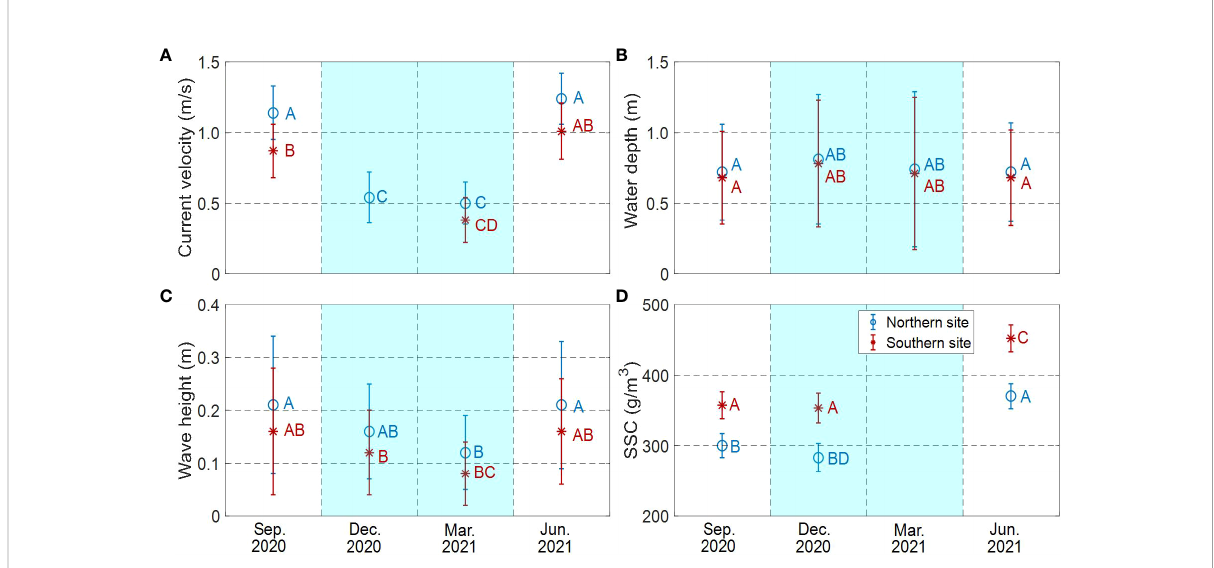
FIGURE 5 Mean and standard deviation values by different seasons and different sites for (A) The current velocity, (B) The wave depth, (C) The signi fi cant wave height, and (D) The suspended sediment concentration. Different letters denote signi fi cant difference (p<0.05) between different treatment. The white background showed the warm seasons. The blue background showed the cold seasons. Different letters denoted signi fi cant differences between treatments.